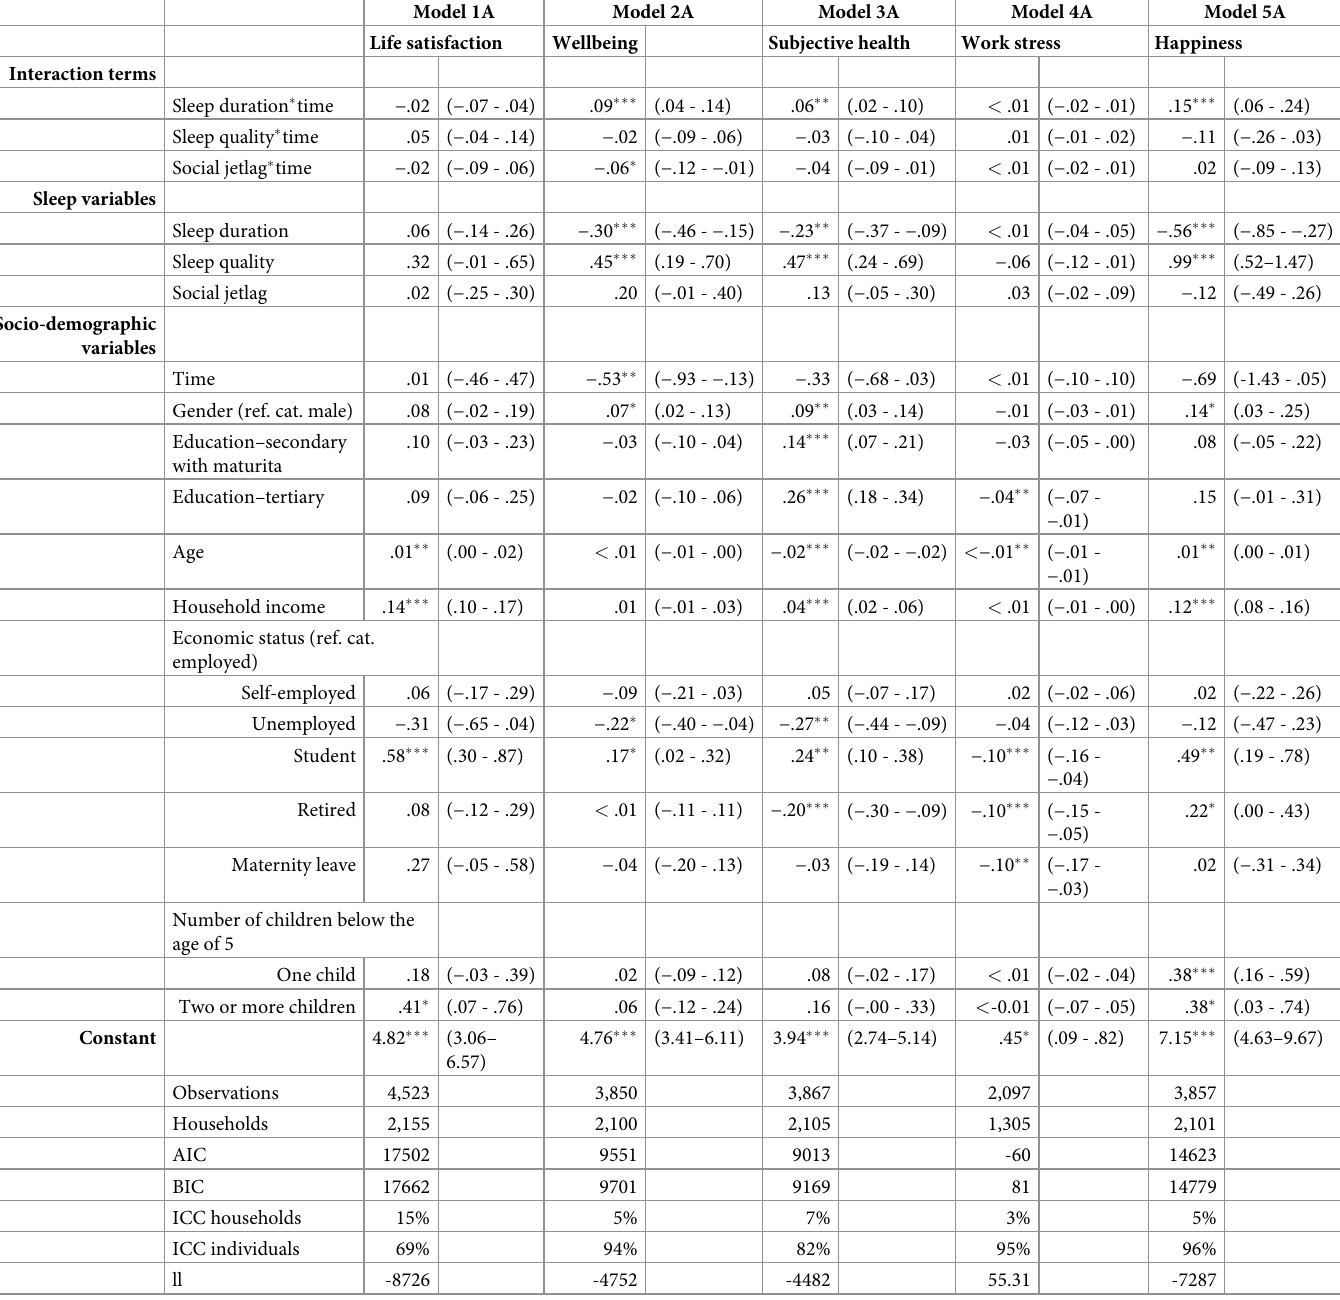
Table 2. Sleeping habits and quality of life, linear mixed models with repeated